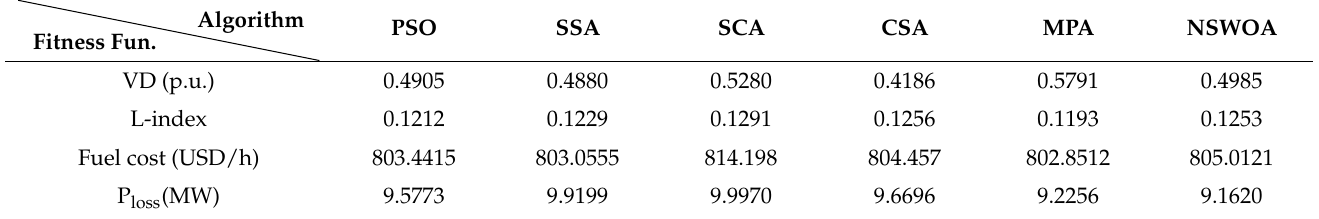
Table 10. Comparison of multi-objective OPF obtained by different optimization algorithms (Case 8).